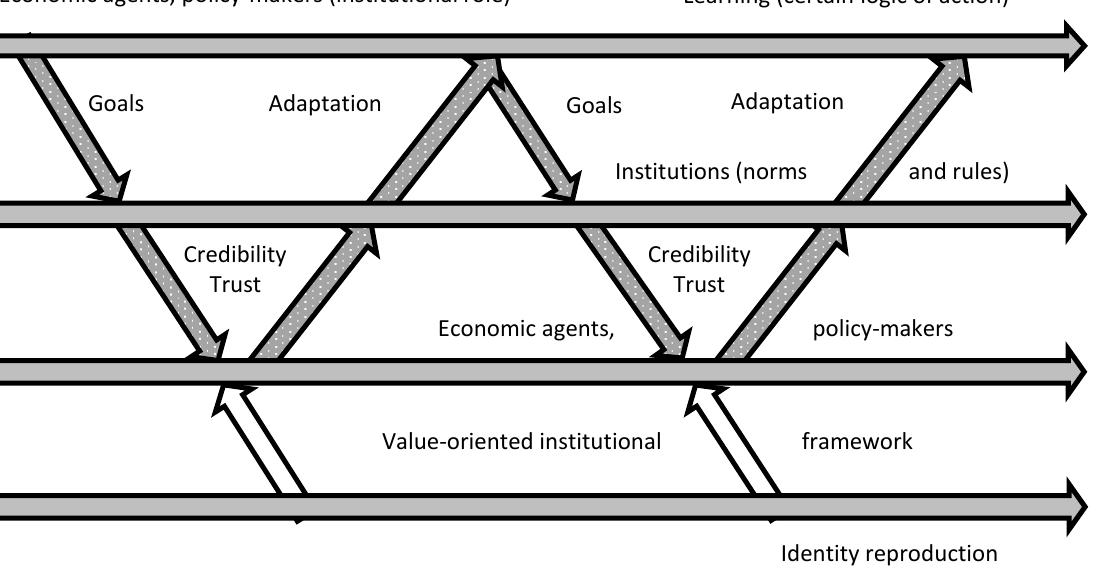
Figure 1. The logic of institutional adaptation through concerted institutional